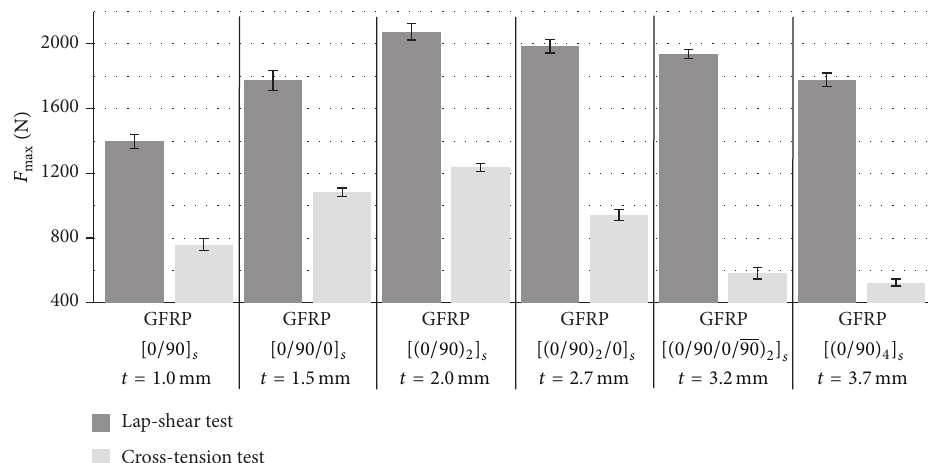
Figure 12: Failure loads of load adjusted hybrid joints in dependence of the FRP thickness, exemplarily illustrated by DC04/GFRP joints.